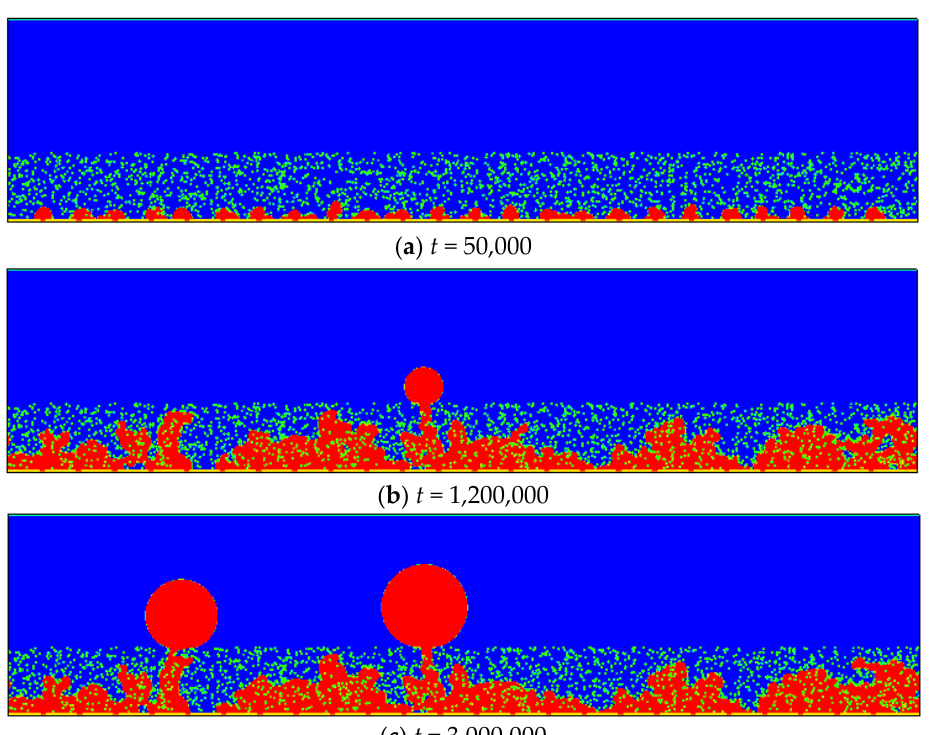
Figure 10. Time evolutions of liquid water distribution in the domain with 16 fractures.